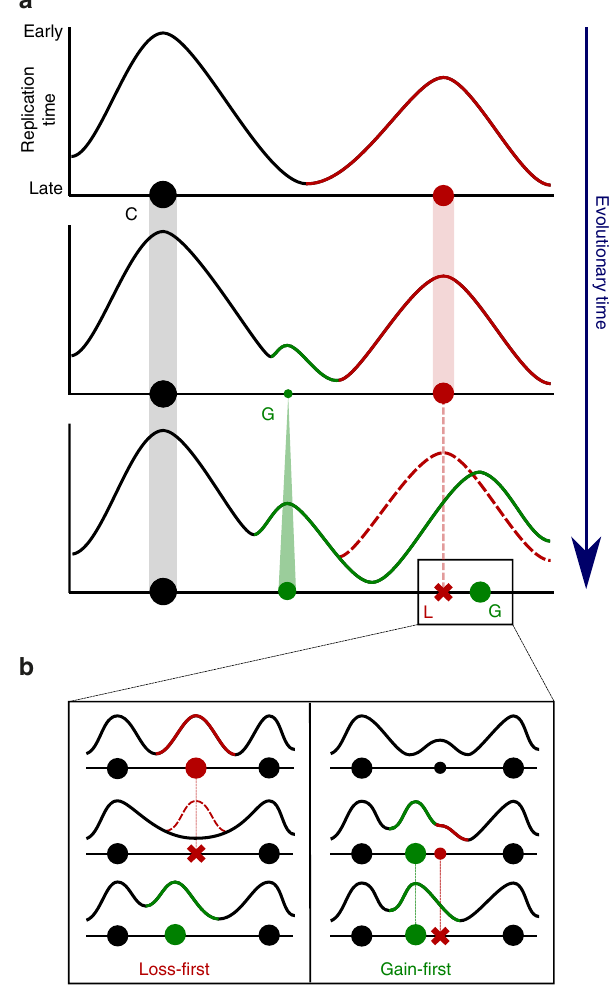
Fig. 5 Evolutionary model of the temporal program of genome replication. a The diagram illustrates fi ve principles governing the dynamics of replication origins at large evolutionary scale: (i) chromosomally active replication origins are continuously gained (G) and lost (L) during evolution, (ii) conserved origins (C) are more ancestral and have on average stronger activity than younger origins, (iii) newly gained origins have on average low activity and their strength increases over evolutionary times, (iv) conserved origins are preferentially lost and (v) origin loss and gain of strong origins occur in a direct chromosomal vicinity. b The two pathways called "Loss- fi rst" and "Gain- fi rst" describe, at shorter evolutionary distances, the coordinated gain of a strong origin with the loss of a strong (left) or weak (right)